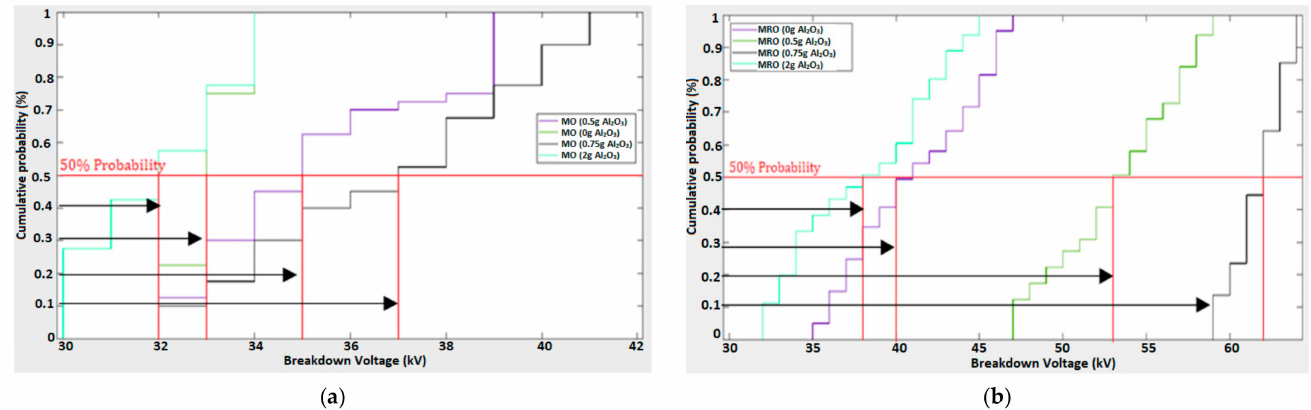
Figure 8. Breakdown voltage density function in different concentration of the Al 2 O 3 , ( a ) MO, ( b )